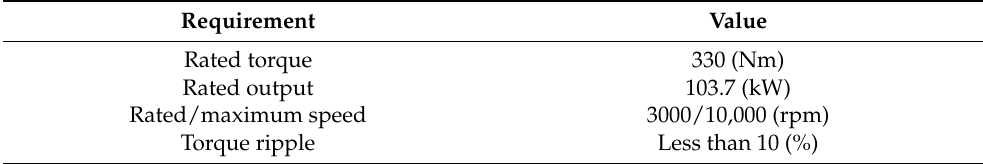
Table 2. Requirements of an objective motor.